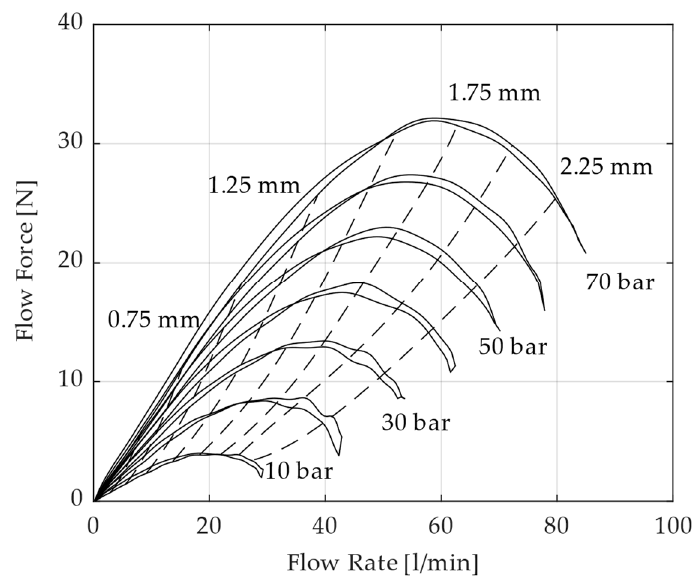
Figure 5. Relationship Between Spool Position, Axial Force and Flow Rate.